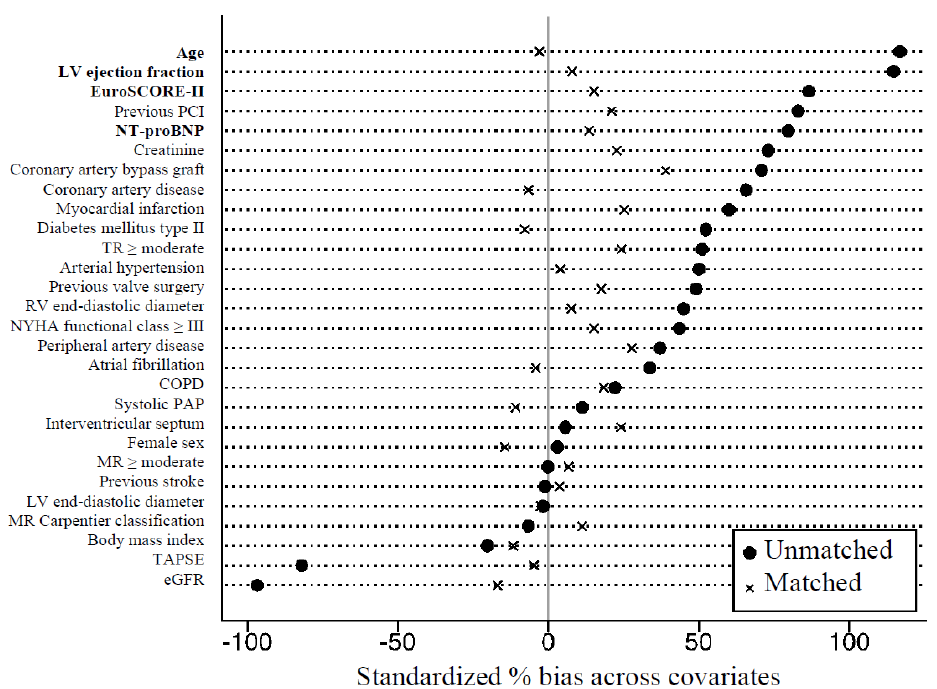
Figure 1. Standardized mean differences across covariates before ( n = 245) and after propensity score matching ( n = 102). Abbreviations: LV, left ventricular; NT-proBNP, N-terminal prohormone of brain natriuretic peptide; PCI, percutaneous coronary intervention; TR, tricuspid regurgitation; RV, right ventricular; NYHA, New York Heart Association; COPD, chronic obstructive pulmonary disease; PAP, pulmonary artery pressure; MR, mitral regurgitation; TAPSE, tricuspid annular plane systolic excursion; eGFR, estimated glomerular filtration rate.